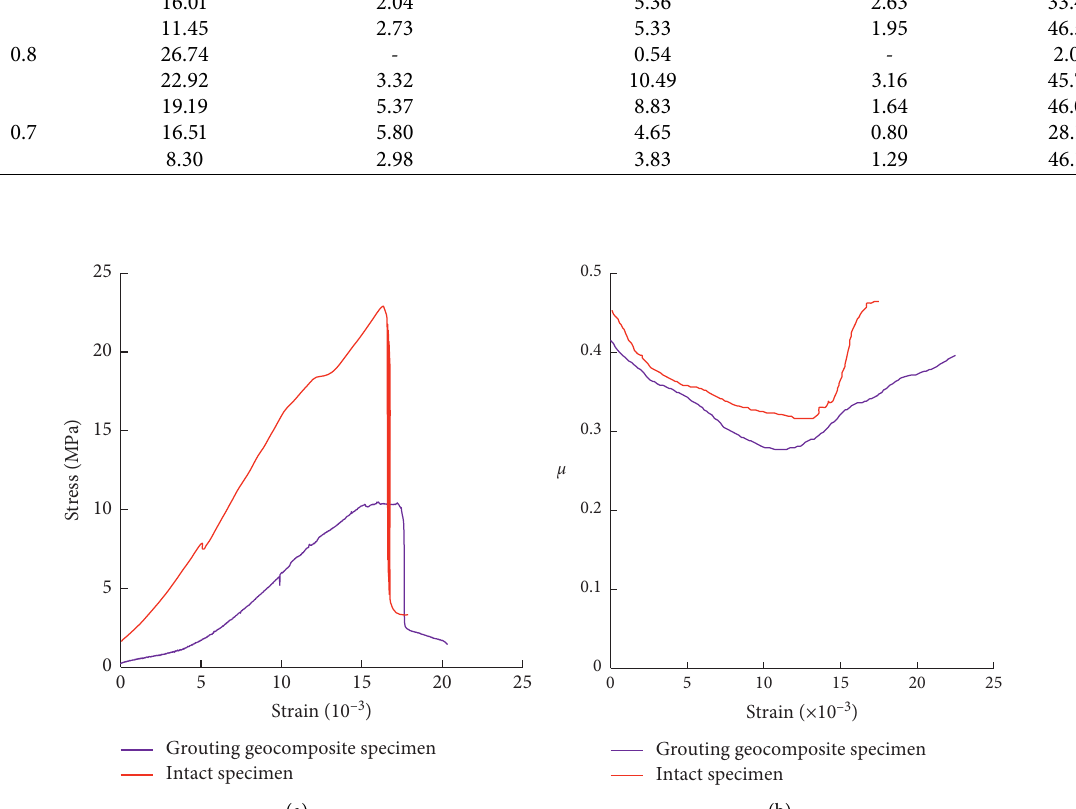
Figure 7: Mechanical properties of coal specimen before and after grouting. (a) Typical stress-strain curve. (b) Typical Poisson’s ratio-strain